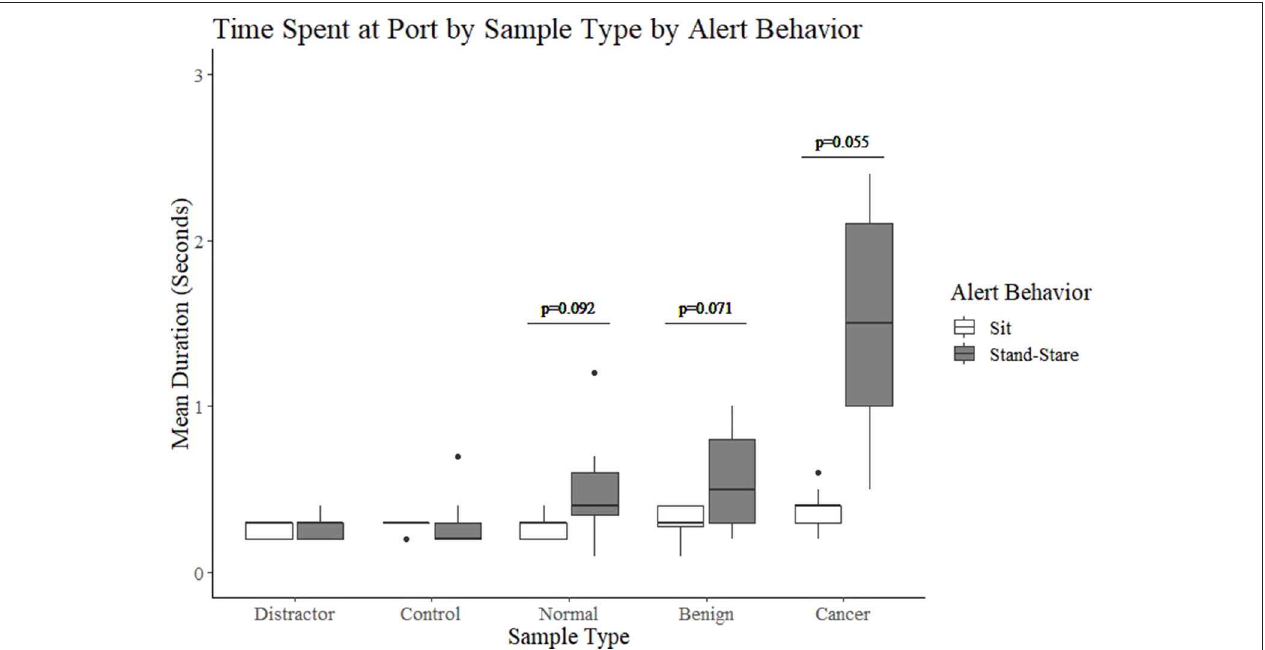
FIGURE 3 | The duration of contact with the port for sit and stand-stare dogs per sample